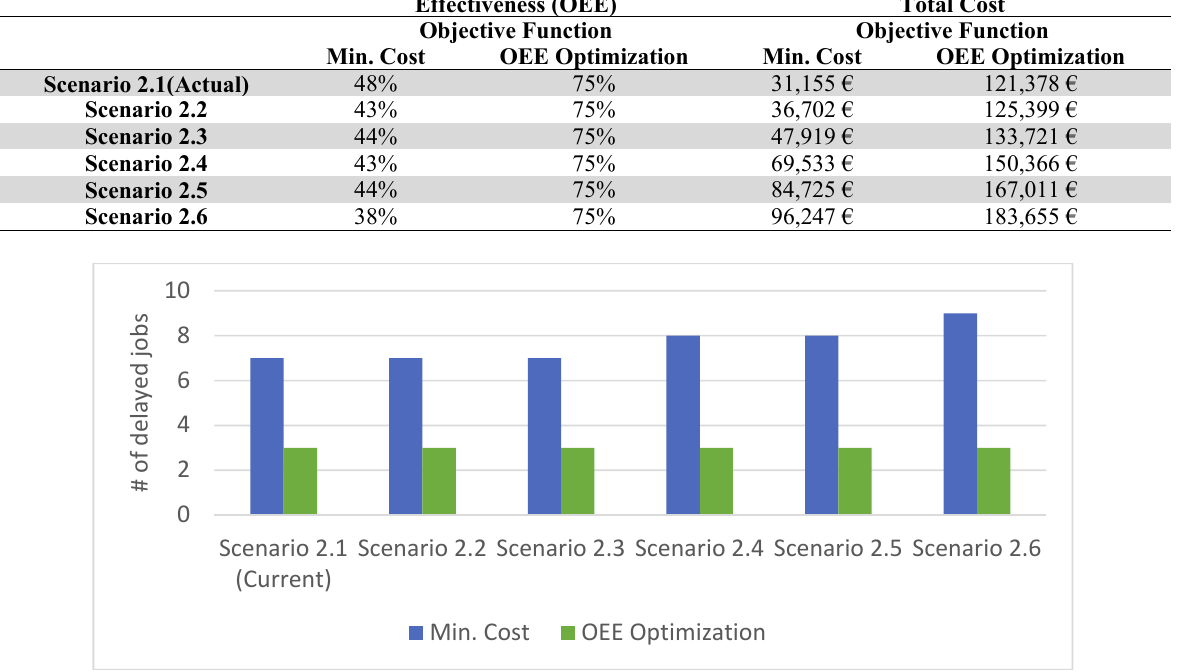
Effectiveness (OEE)